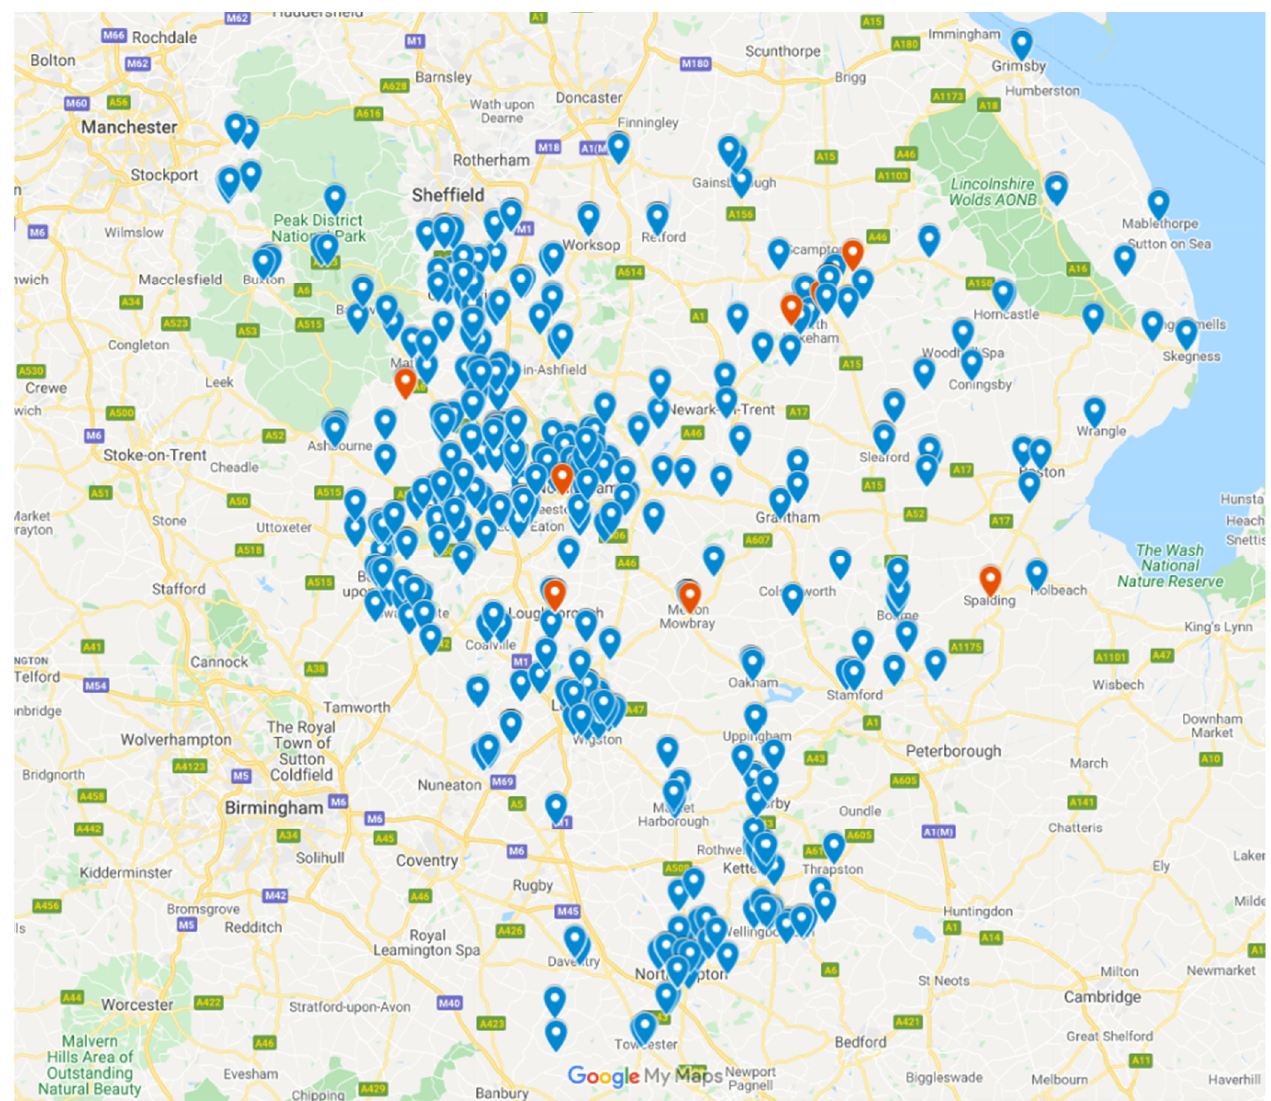
Figure 1. Point location map of classes in the East Midlands. Table 1. Number of classes and population over 65